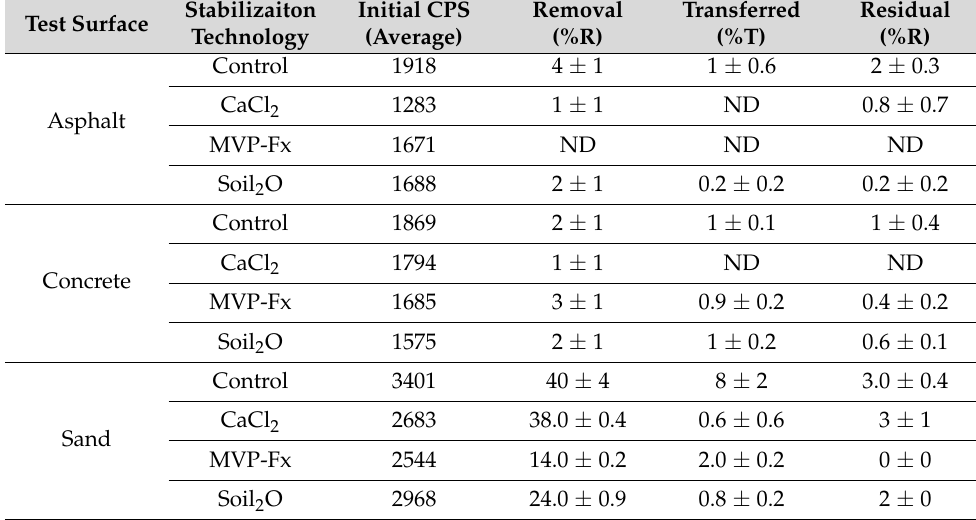
Table 7. Efficacy of stabilization technologies for simulated foot traffic experiments, expressed as average ± standard